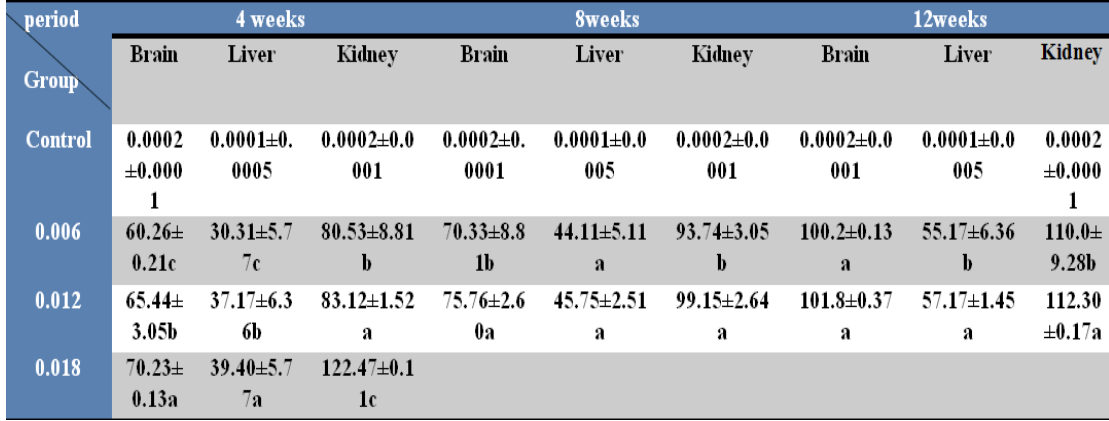
Different small letters means significant ( p <0.01) results between